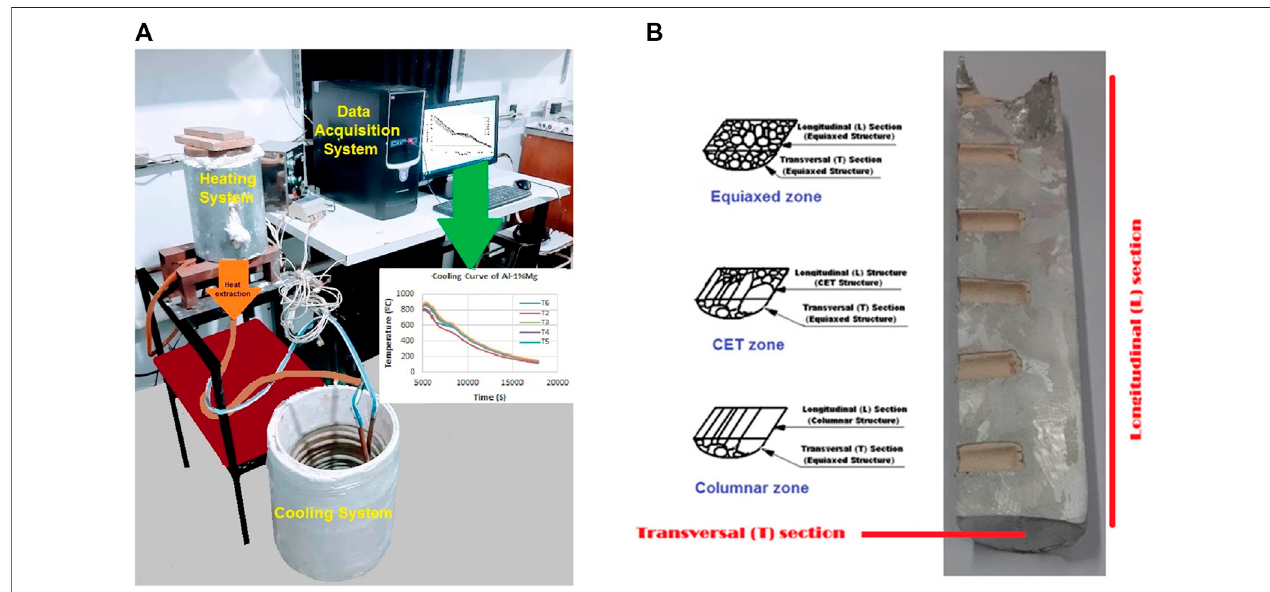
FIGURE 1 | (A) Experimental setup used in directional solidi fi cation experiments. (B) The longitudinal (L) and transversal (T) sections of the cylindrical sample.